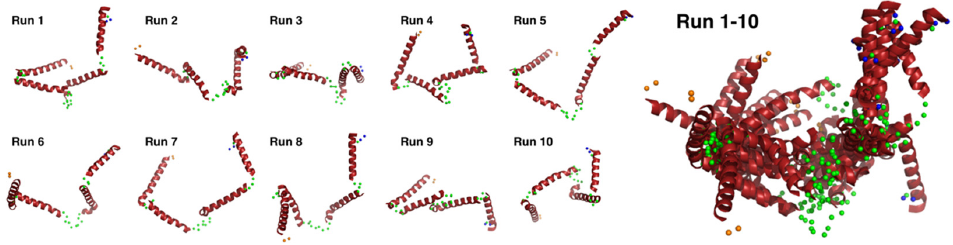
Figure 6. Ten individual BUNCH simulated structures and their superimposed structures. The BUNCH simulations were carried out with four rigid helixes (red), three linkers (green), N-terminal residues (orange), and C-terminal residues (blue).